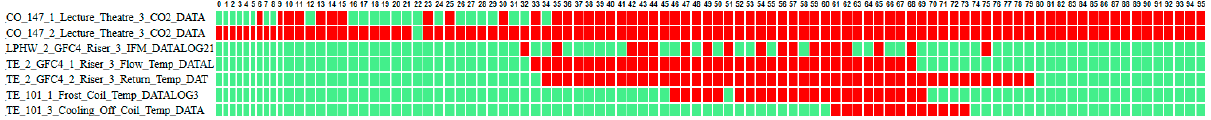
Figure 7. T 2 Signatures of an abnormal day (20 January 2018). Y axis contains the variables and X axis the time (quarterly sampled). Green represents variables/time in the model space and red represents variables/time out of the model space. The two CO 2 sensors are detected as abnormal along with some temperature related variables during the hours with presence in the room. Variables without abnormal contributions are not